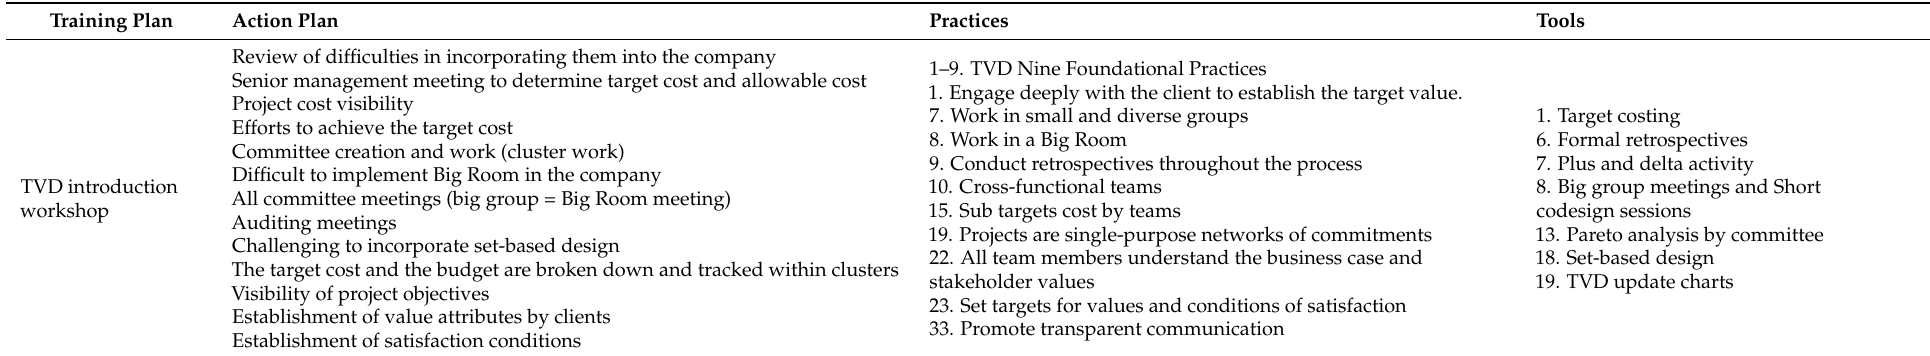
Table A3. TVD practices and tools learned and applied in the training-action plan (based on Table